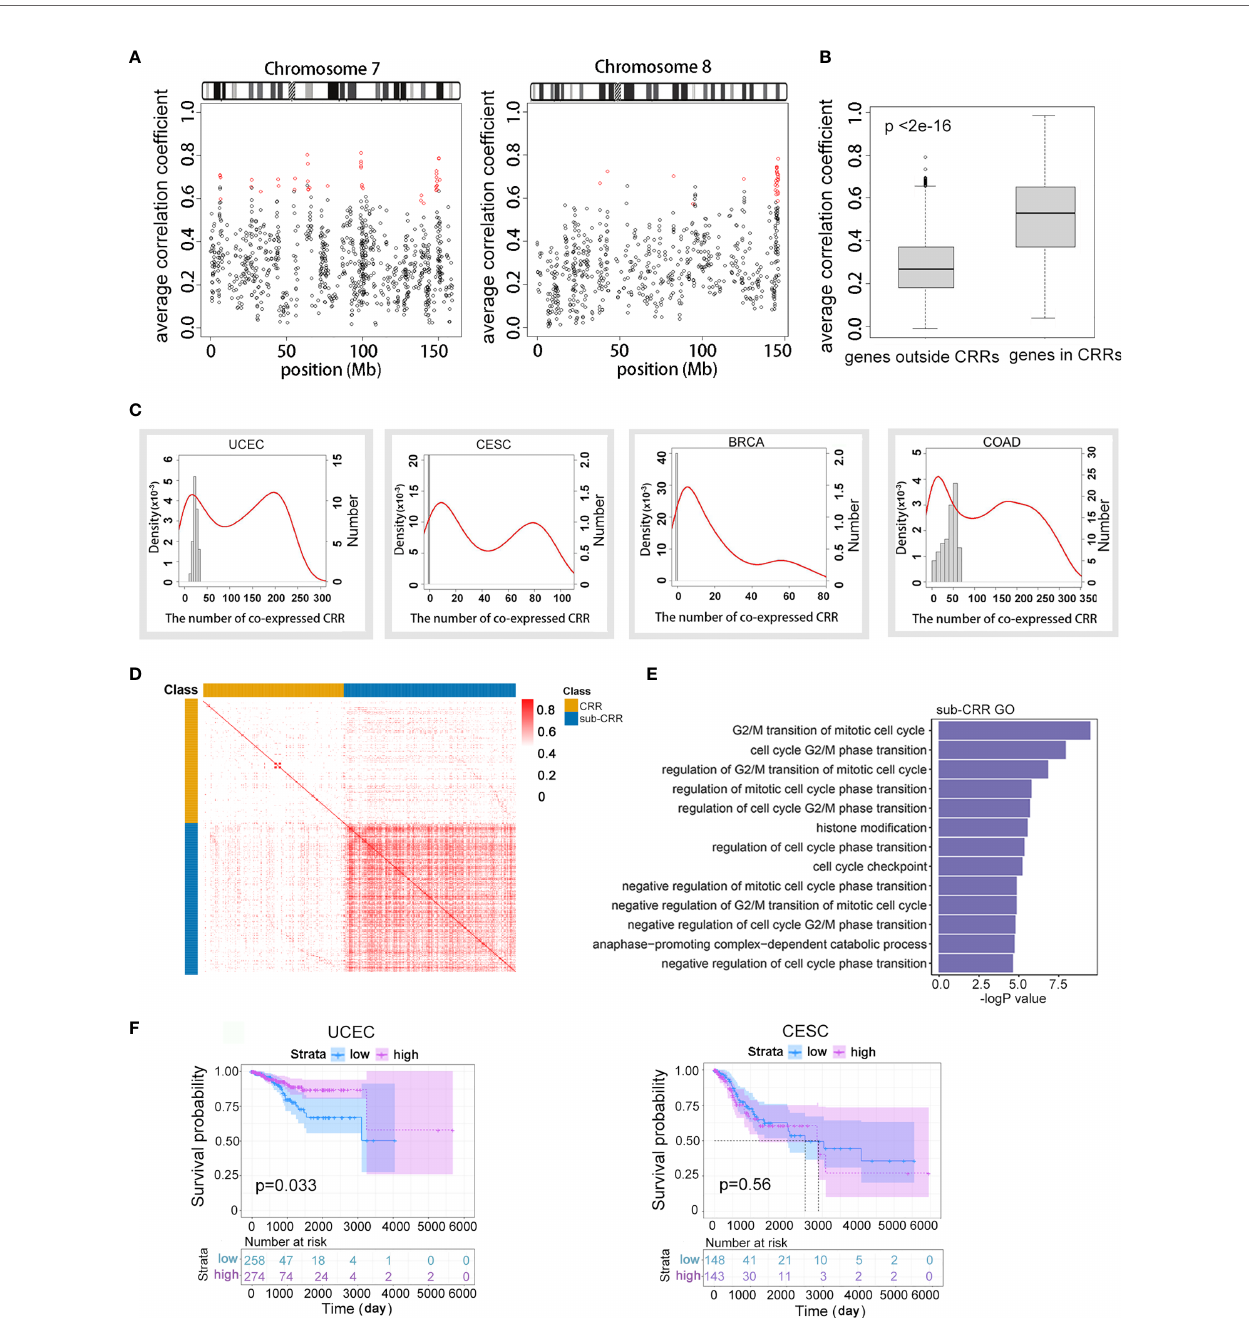
FIGURE 1 | Subset of coordinately regulated regions (Sub-CRRs) exhibited high inter-correlations and were associated with cancer patient survival. (A) The average correlation coef fi cient of each gene with the expression value of four neighbor genes was calculated and mapped on chromosomes 7 and 8 using UCEC data. Red represents CRR regions. (B) Boxplots showing the distribution of the average expression correlation coef fi cient of genes in CRRs and genes outside CRRs using TCGA UCEC data. (C) Distribution of CRRs that have an expressional correlation with other CRRs in different cancer genomes. The red density curves correspond to the left ordinate, depicting the proportion of CRR with signi fi cant correlation (p < 0.05) with other CRRs; horizontal coordinates indicate the quantities of “ other CRRs ” . For example, a point (x, y) on the red curve indicates a group of CRRs; each of them has a signi fi cant correlation with x (the quantity) other CRRs, and the proportion of such group of CRRs compared with the whole is y × 10 -3 . The histogram corresponds to the right ordinate, depicting the number of CRRs with a signi fi cant correlation (p < 0.05) with others under random conditions. (D) Heat map of the absolute value of correlations between CRRs. Sub-CRRs are arranged in the blue area while other CRRs are in yellow. Red plots indicate high correlation. (E) GO analysis indicated signi fi cantly enriched (p < 0.05) items in sub-CRR genes. (F) Survival curves of patients with UCEC and CESC classi fi ed by expression of genes in